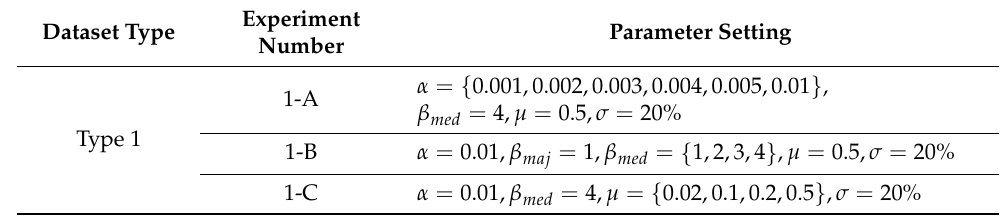
Table 5. Experimental parameter settings of Type 1.